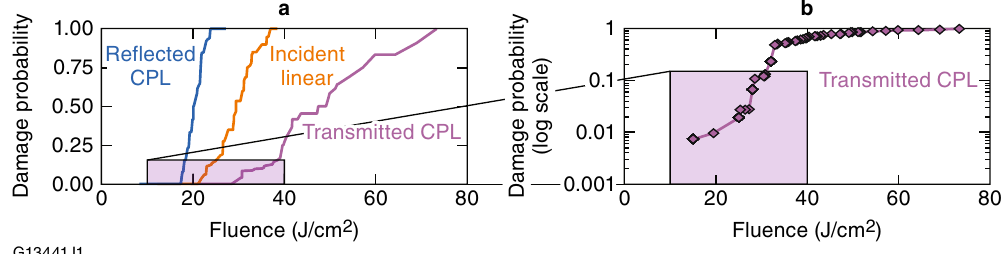
Figure 4. ( a ) Damage probabilities for the chiral-nematic LC device containing NU131-LCP as a function of 1053-nm, 1.4-ns laser fluence and incident polarization. ( b ) Damage probabilities for transmitted CPL pulses incident on the device at low fluence [corresponding to the inset in Fig. 5(a)]. These damage probability data are plotted on a logarithmic scale and represent an additional 250 sites of 1-on-1 damage data collected by line- scanning the sample.